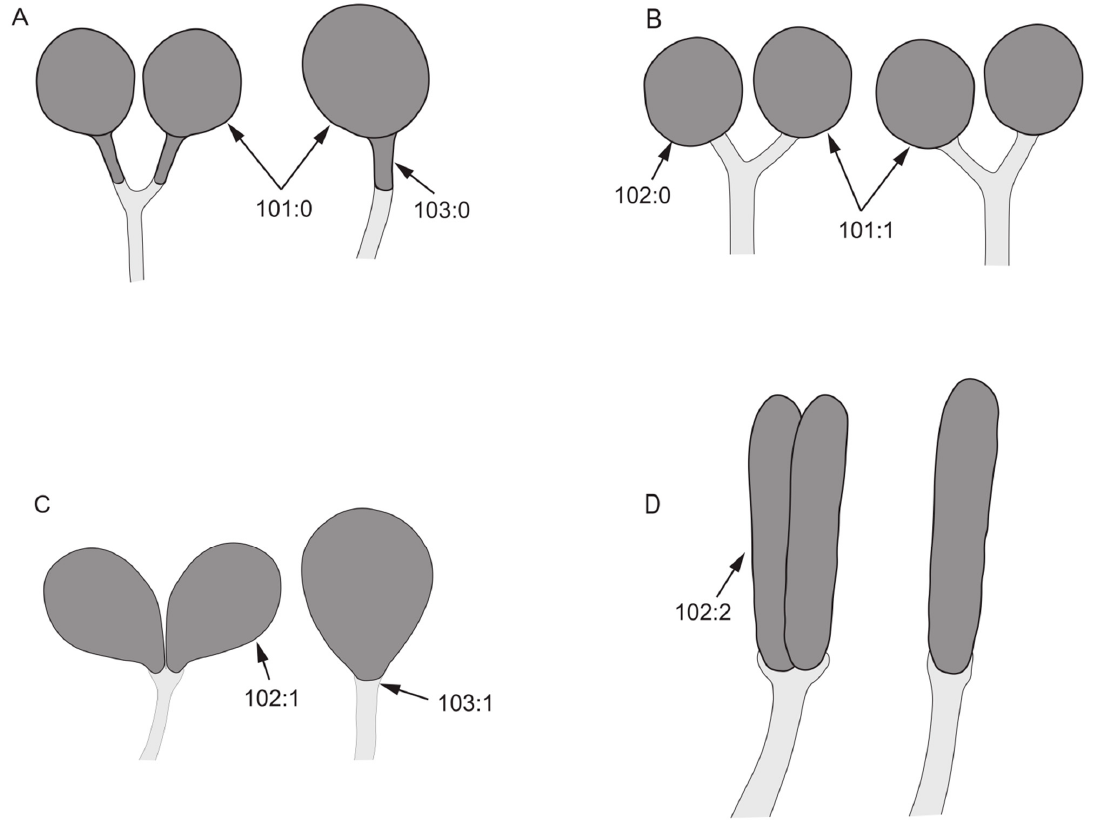
Figure 9. Spermathecae characters. ( A ): Minettia ( Frendelia ) longipennis ; ( B ): Noonamyia umbrellata